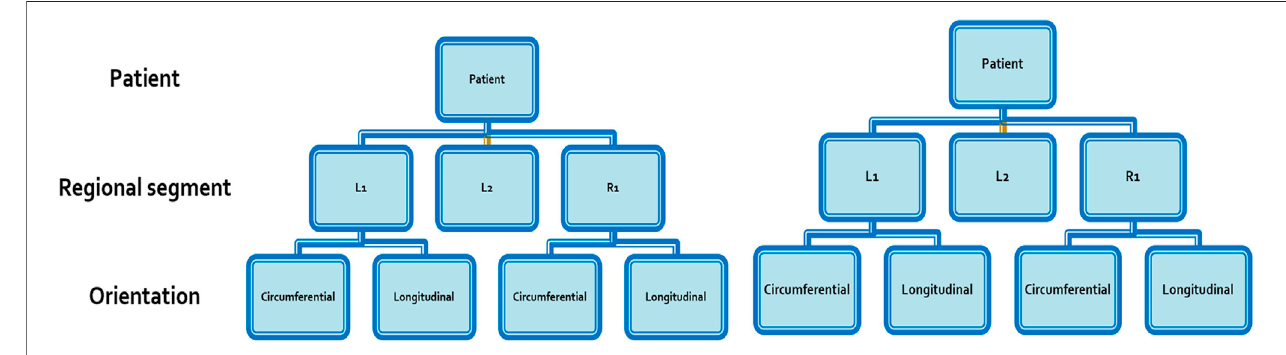
FIGURE 3 | Hierarchical structure of data arising from each aortic